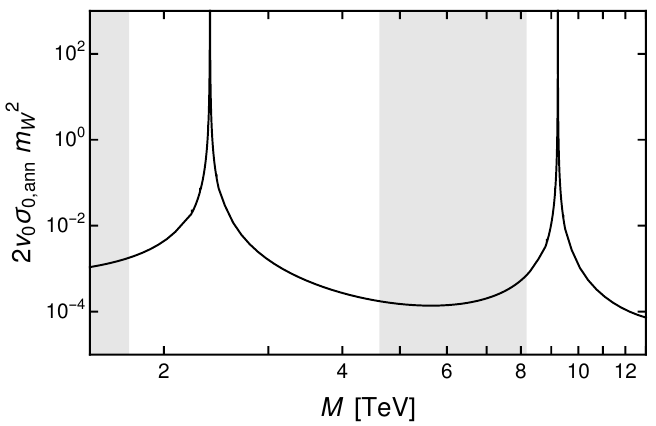
Figure 11 . Neutral-wino-pair annihilation rate 2 v 0 (cid:27) 0 ; ann at zero energy as a function of the wino mass M . The peaks have (cid:12)nite maxima that are too large to be visible. The grey regions are the ranges of M in which j (cid:13) 0 j > m W , so a ZREFT for neutral and charged winos is not applicable.